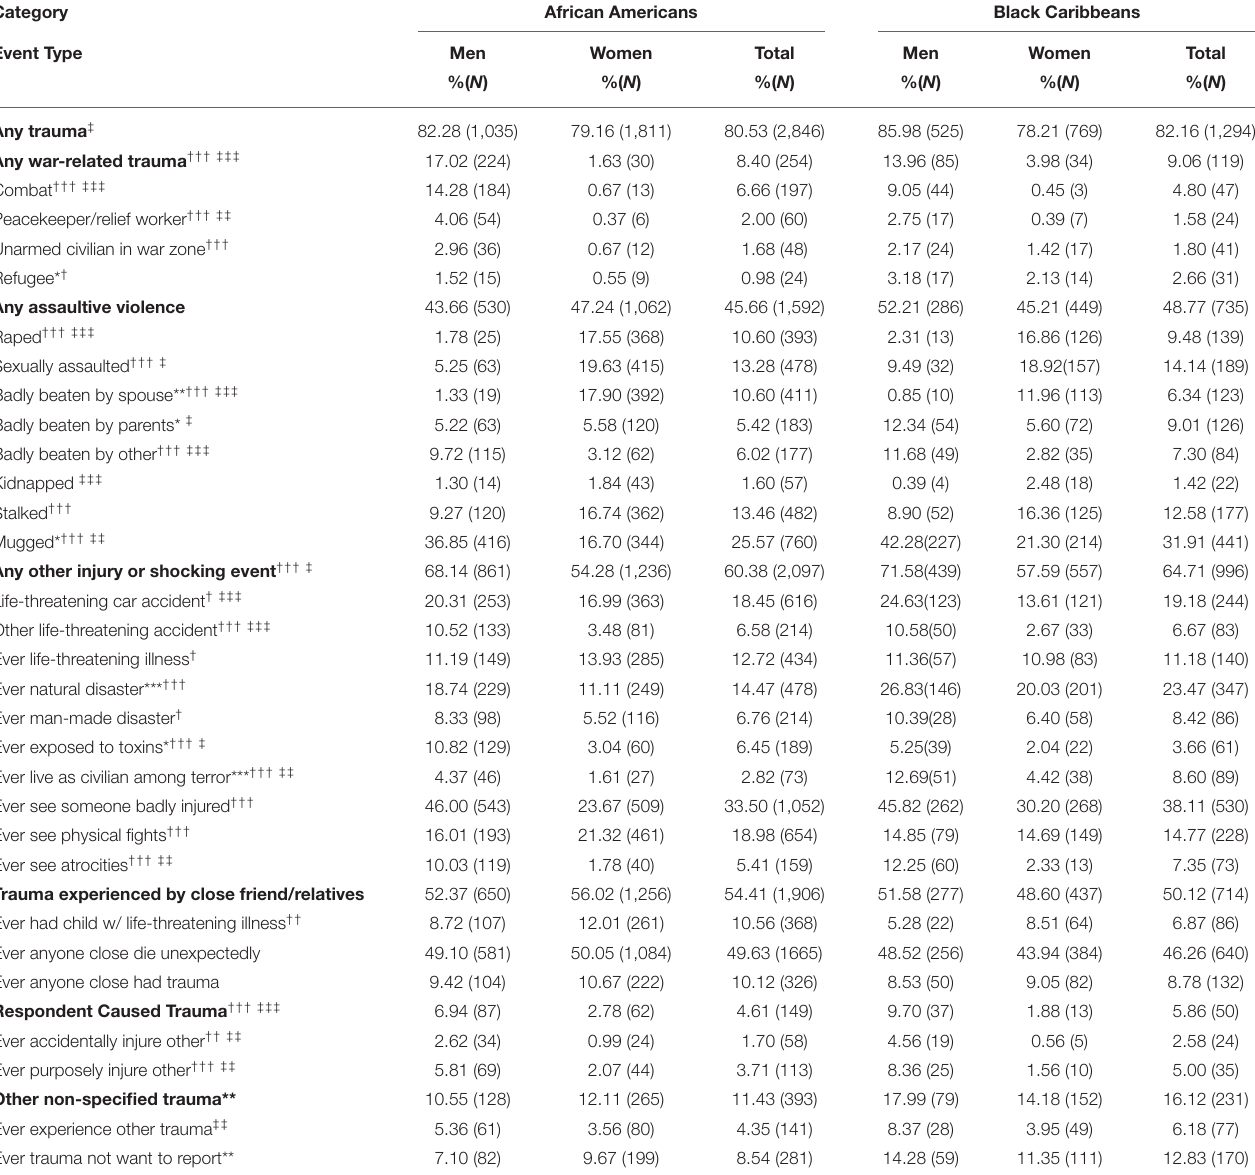
TABLE 1 | Sex and ethnic differences in lifetime exposure to potentially traumatic events for African Americans and Black